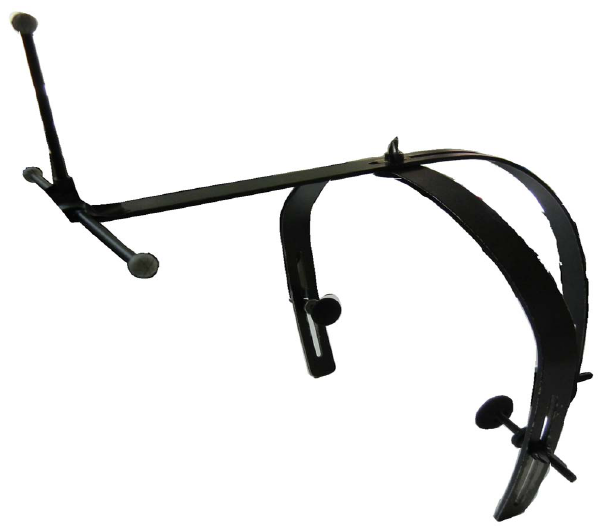
Figure 4. Specialized helmet.